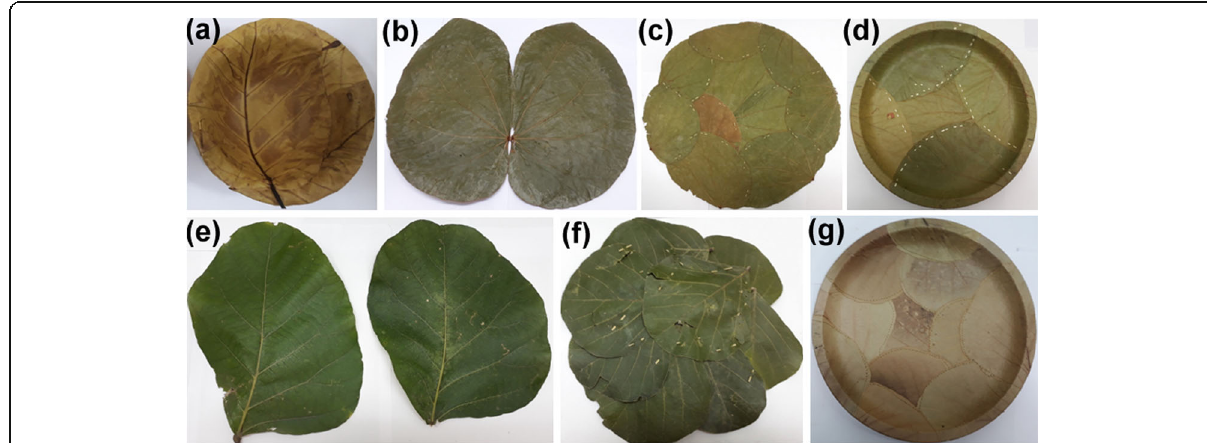
Fig. 1 a The machine compressed cup made from the leaves of sal , S. robusta , ( b ) the bilobed leaf of addaku , P. vahlii , ( c ) the hand stitched and ( d ) machine compressed dining plates made from the leaves of addaku , ( e ) the leaves of moduga , B. monosperma , ( f ) the hand stitched and ( g ) machine compressed dining plates made from the leaves of